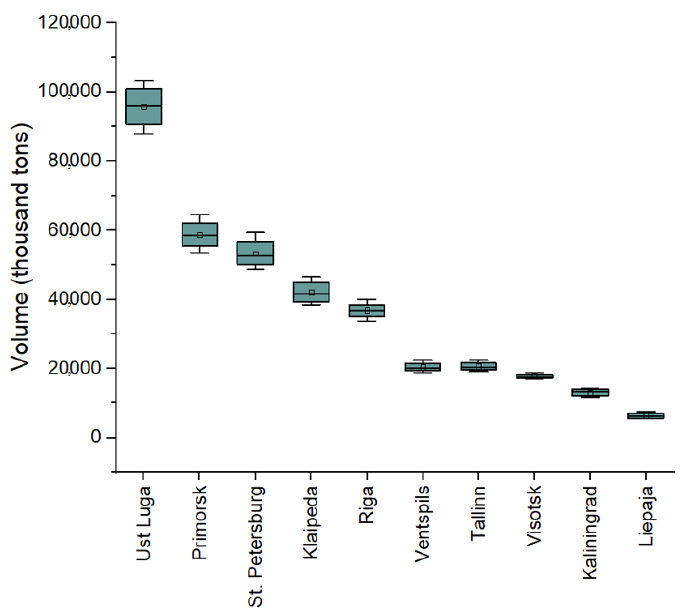
Figure 24. Distribution of cargo flows in ports of the eastern Baltic coast in 2019 – 2020 (during the COVID-19 pandemic).